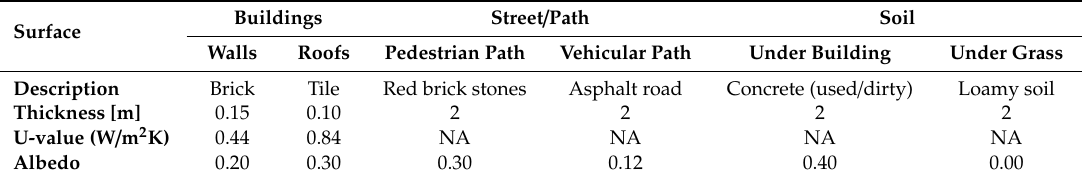
Table 7. Materials setting applied in the ENVI-met model.